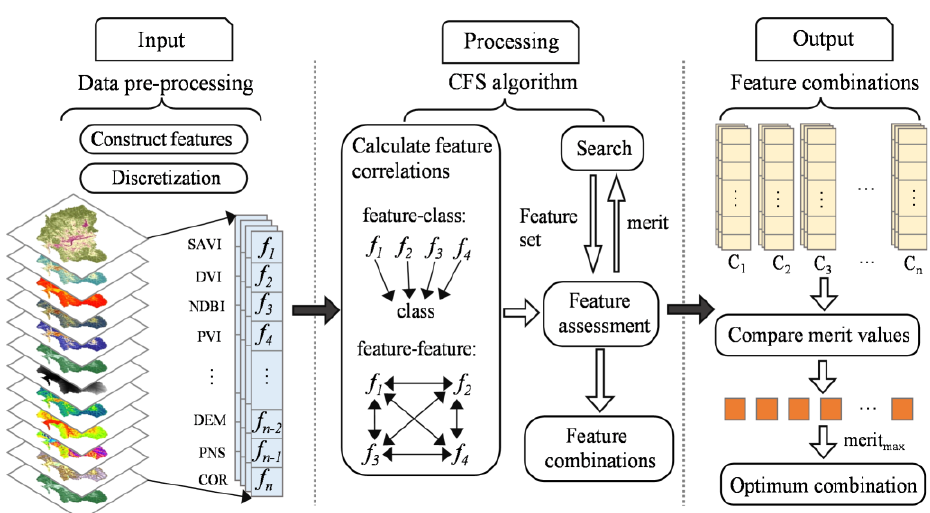
Figure 4. Feature selection and combination process based on the CFS algorithm.